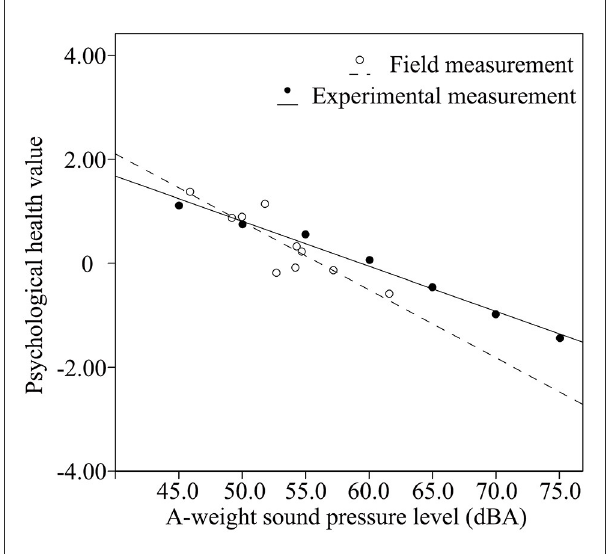
FIGURE3 Relationship between L Aeq and psychological health values within the emotional dimension.